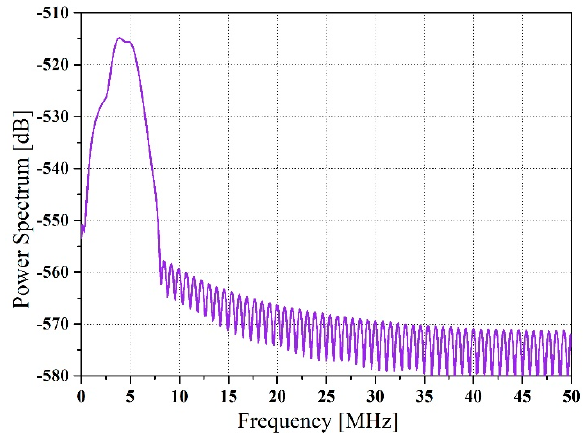
Figure 5. The block power spectrum.